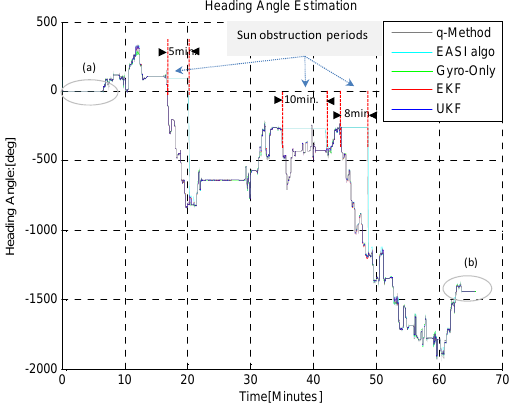
Figure 21. Heading angle (unwrapped) estimated by different algorithms during the one hour dynamic test.